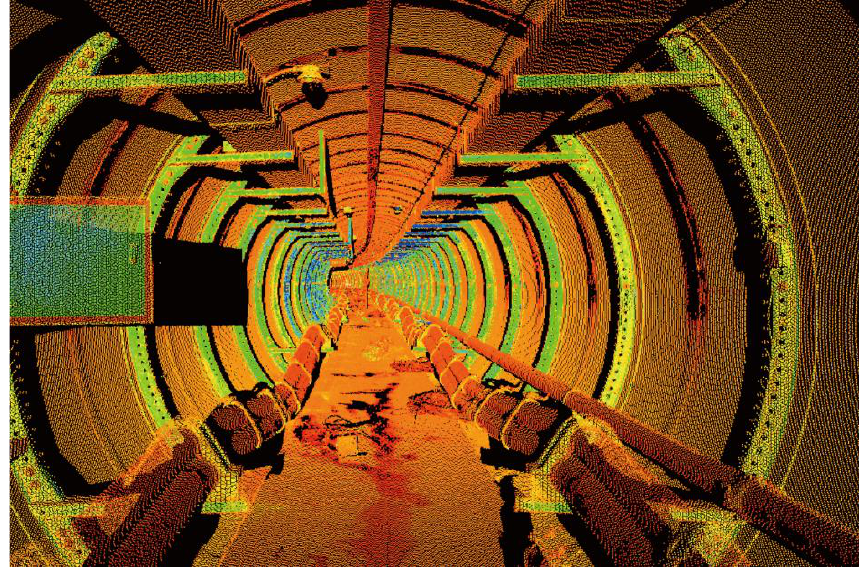
Figure 6. 3D point cloud obtained from a field experiment.